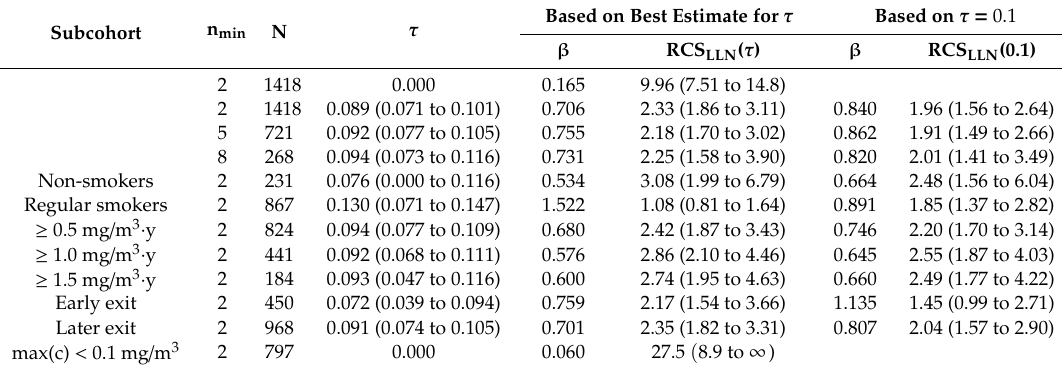
Table 1. Estimates for the reference dose of respirable crystalline silica based on threshold models and random e ff ects maximum-likelihood regression (95%CI in parentheses). Based on Best Estimate for τ Based on τ = 0.1 Subcohort n min N τ